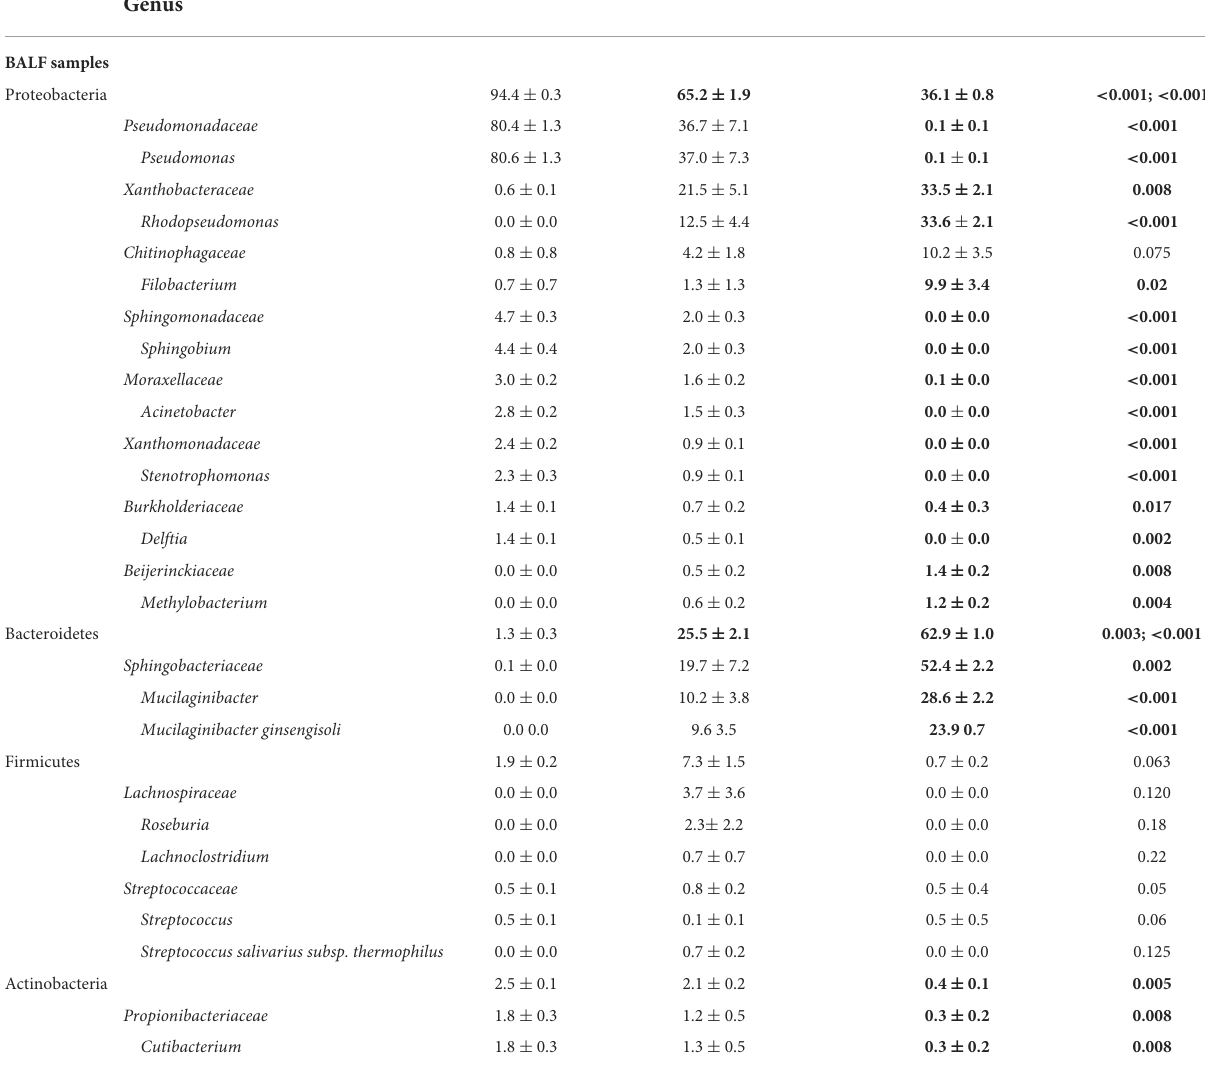
TABLE 3 Relative abundance (mean ± SEM) of taxa at the level of family and genus present in any lower airway sample at any time point at > 0.5% accounting for > 90% of the overall microbial community. Phylum